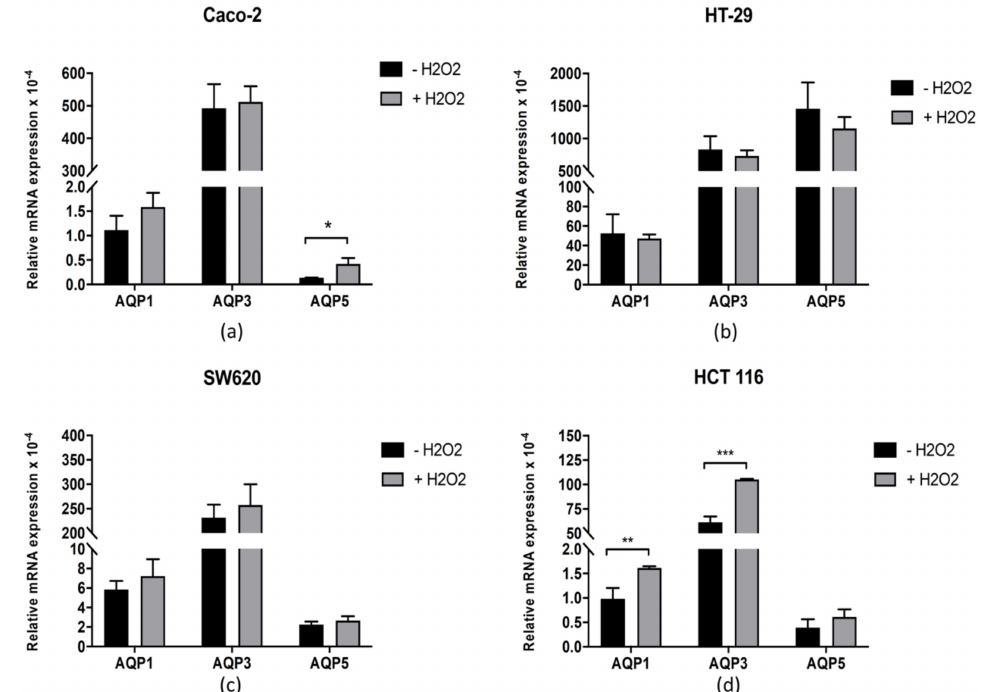
Figure 4. Effect of oxidative stress on AQP1, AQP3, and AQP5 expression. AQP1, AQP3, and AQP5 mRNA expression level in ( a ) Caco-2, ( b ) HT-29, ( c ) SW620, and ( d ) HCT 116 cell lines. Cells were incubated (or not) with 100 µ M H 2 O 2 for 24 h at 37 ◦ C in 5% CO 2 . Data represent mean ± SD from three independent experiments. Significance levels: * p < 0.05, ** p < 0.01 and *** p < 0.001.